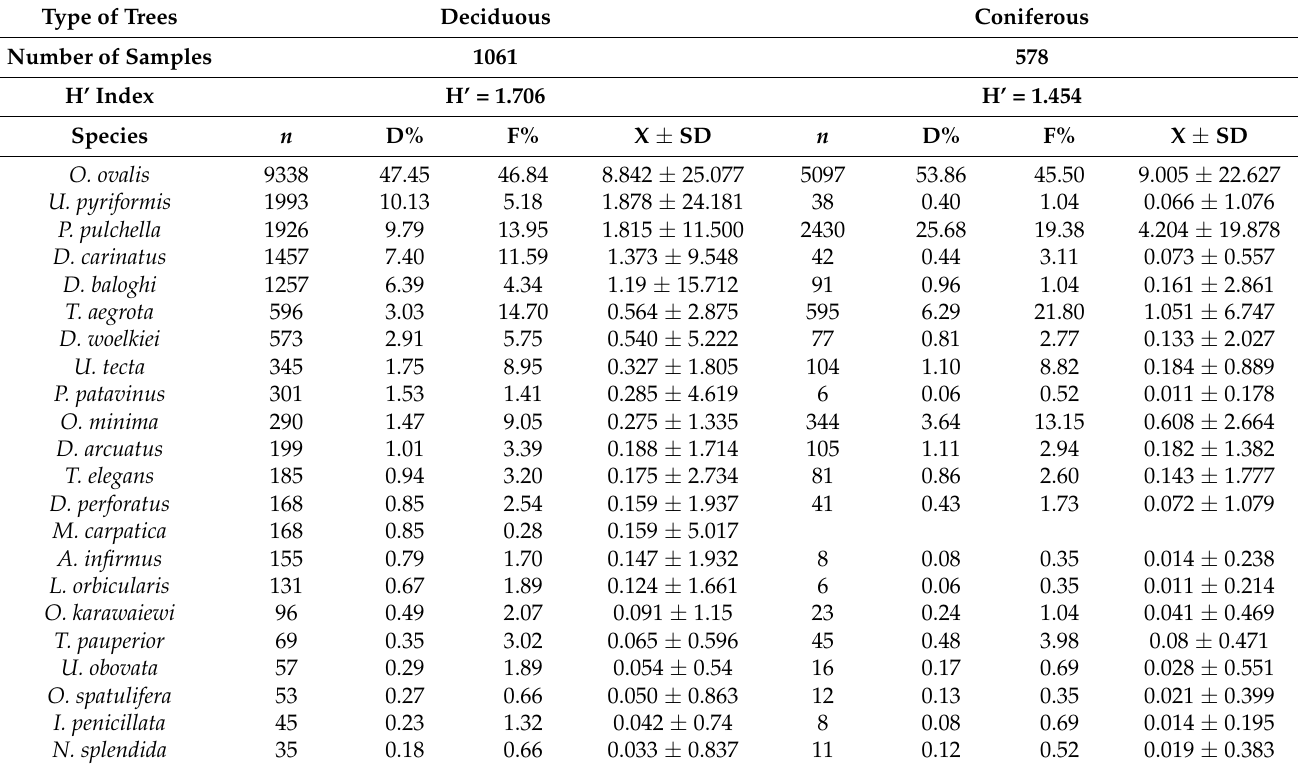
Table 1. Community structure of Uropodina mites in dead wood of deciduous and coniferous trees. n —number of specimens, D—dominance, F—frequency, X ± SD–average ± Standard